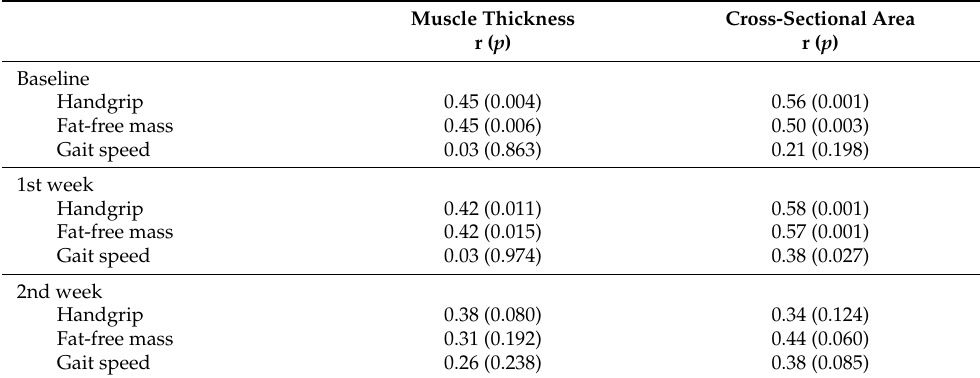
Figure 3. Differences in muscle thickness and muscle cross-sectional area of rectus femoris among groups (Pre-frailty vs. Frailty) evaluated with two-way analysis of variance. The mean values and the standard error of the mean are shown. Abbreviations: CSA: Cross-sectional area, MT: muscle thickness, RF: Rectus femoris muscle, CI: Confidence Interval. Table 4. Pearson correlation coefficients of muscle thickness and cross-sectional area of the rectus femoris assessed by ultrasound with current sarcopenia diagnostic criteria during hospitalization in the post-acute care unit (n =